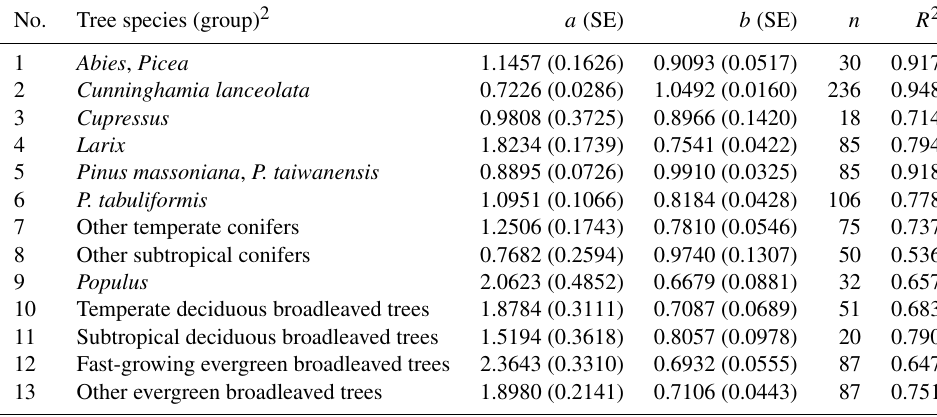
Table B1. Height–diameter curves for China’s tree species (group) 1 .